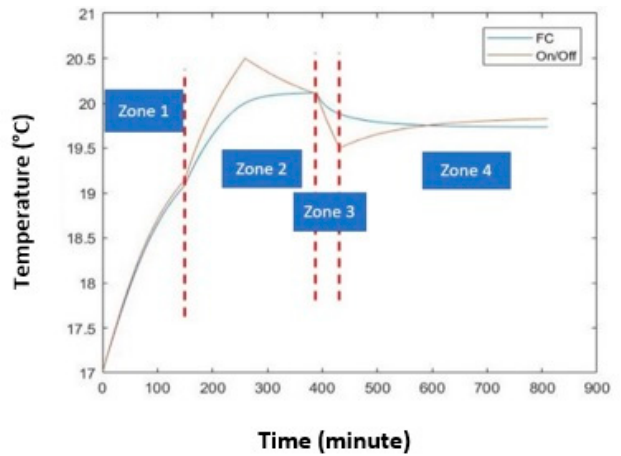
Figure 18. Valve position variations ( ϑ P ( t ) ) regarding the FC and On/Off controller during experi- Figure 18. Valve position variations ( 𝜗 (cid:3017) (𝑡)) regarding the FC and On/Off controller during the Figure 18. Valve position variations ( 𝜗 (cid:3017) (𝑡)) regarding the FC and On/Off controller during the Figure 18. Valve position variations ( 𝜗 (cid:3017) (𝑡)) regarding the FC and On/Off controller during the mentation in a practical classroom with a large size. Zone: It remarks different conditions during experiment in an office room with a small size. Zone: It remarks different conditions during the experiment in an office room with a small size. Zone: It remarks different conditions during the experiment in an office room with a small size. Zone: It remarks different conditions during the the experiments. experiments. experiments. experiments.